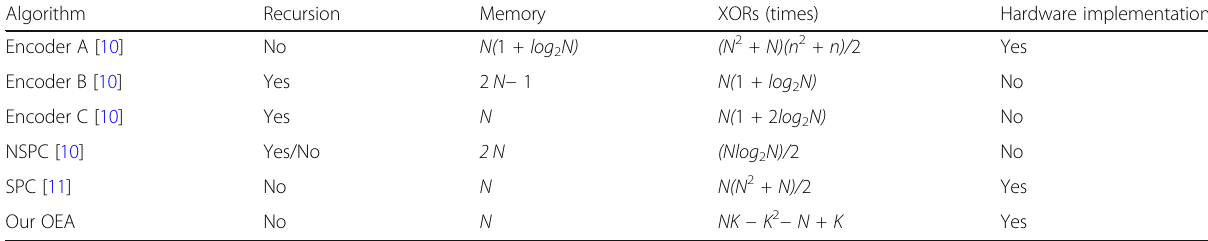
Table 4 Comparison of systematic polar encoders